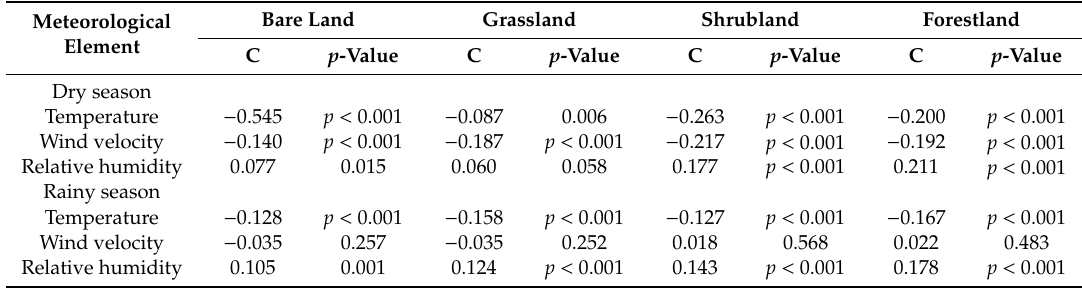
Table 13. Results of the Spearman correlation coe ffi cient (C) and significance level ( p ) between volumetric soil moisture content, and temperature, wind velocity, and relative humidity in a period without rainfall.